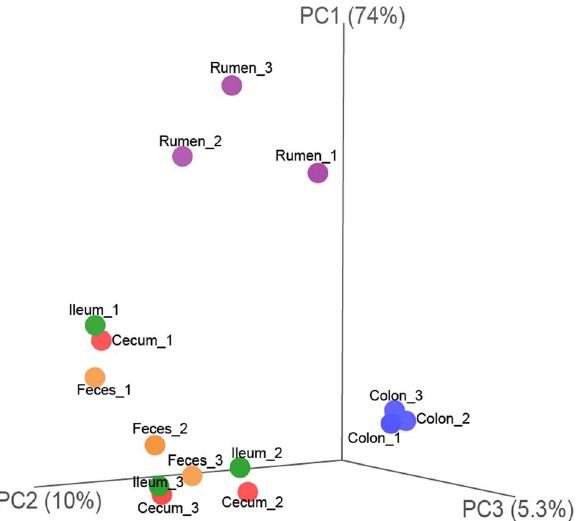
Figure 1. 16S rRNA gene surveys reveal hierarchical partitioning of all 15 samples. Bacterial communities were clustered using principal coordinate analysis of the full-tree-based Unifrac matrix. Each point corresponds to a sample colored to indicate locations in the GIT. Three principal components (PC1, PC2, and PC3) explained 89.3% variation.